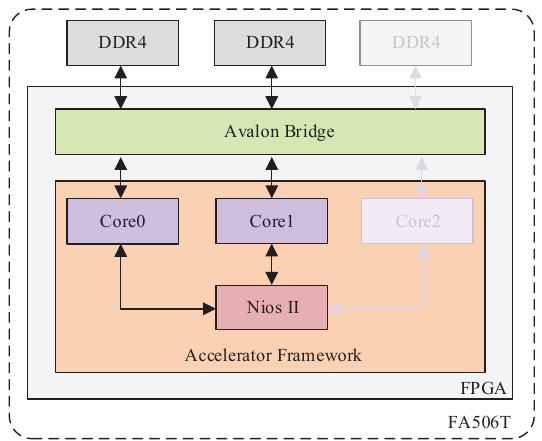
Figure 10. Block diagram of the evaluation system. The number of accelerator cores is configurable, which is determined by FPGA resource and off-chip access